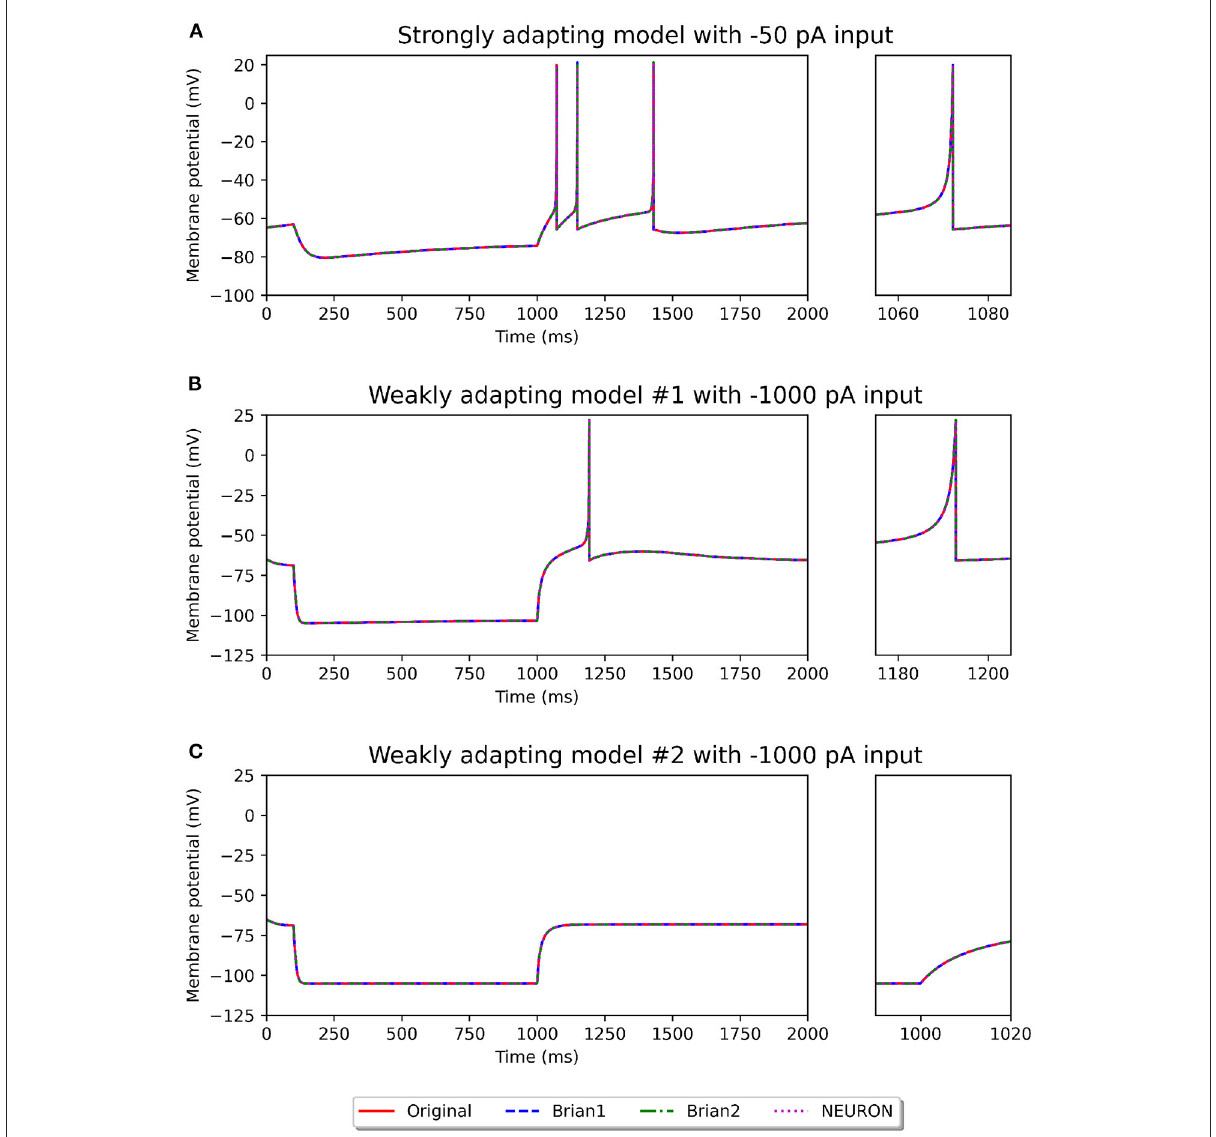
FIGURE3 Recording of membrane potential in the different model variants following a hyperpolarizing stimulus. The stimulus strengths were chosen based on the examples in the original study: − 50 pA stimulus for the strongly adapting models (A) , and − 1,000 pA stimulus for the weakly adapting models (B,C) . Rebound spiking is observed in the Pyr_Strong and Pyr_Weak1 models, but not in the Pyr_Weak2 models. The smaller panels on the right provide a closer view of part of the